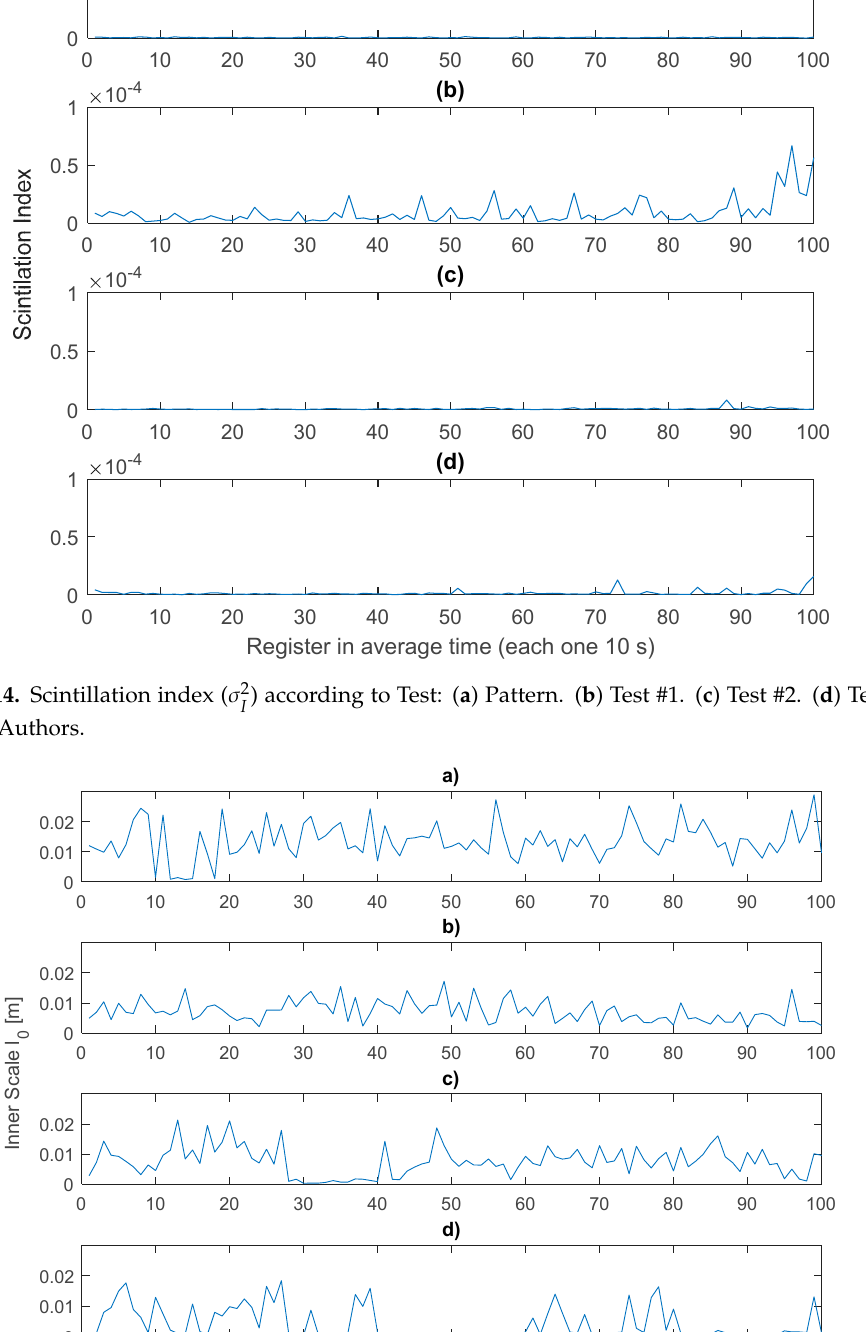
Figure 15. Inner Scale ( l 0 ) according to Test: ( a ) Pattern. ( b ) Test #1. ( c ) Test #2. ( d ) Test #3. Source: Authors.